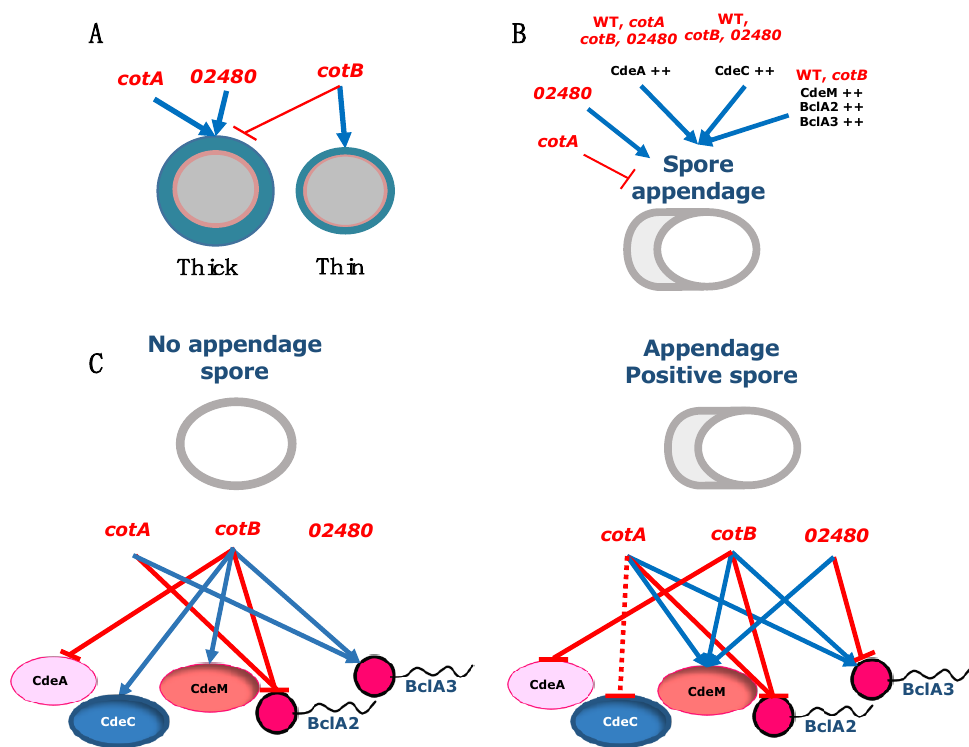
Figure 7. Schematic representation of the impact of inactivation of spore coat genes and multicopy expression of selected exosporium proteins on relevant spore phenotypes . ( A ) CotB contributes to the formation of thick-exosporium spores, while CDIF630_02480 negatively regulated the thickness of the electron-dense material in thick-exosporium spores, derived from results in Figure 2. ( B ) The formation of spores with a polar appendage is positively and negatively regulated by the spore coat proteins, CotA and CDIF630_02480, respectively, while the exosporium cysteine-rich (CdeA, CdeC and CdeM) and the collagen-like BclA2 proteins positively contribute to the formation of appendage-positive spores derived from results in Figure 3. ( C ) Representation of the association between the spore coat proteins CotA, CotB and CDIF630_02480 on the surface accessibility to anti-flag antibodies of the exosporium proteins CdeA, CdeC, CdeM, BclA2 and BclA3 derived from results of Figure 5 and Figure 6. Blue arrows denote a positive association; dotted blue arrows denote a slight positive association; and red arrows denote a negative association.